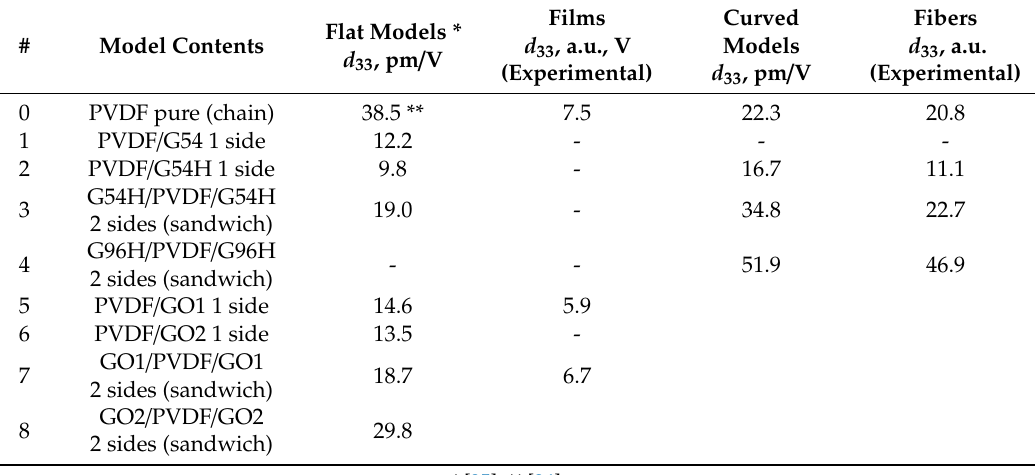
Table 2. The piezoelectric coe ffi cients d 33 calculated for di ff erent types of structures (flat and curved) of Graphene Oxide with and PVDF (in comparison with the data from other works [24,25], in an electric field Ez ~500 GV / m, and with experimental data obtained in the present study; the presented values have absolute value (without natural negative